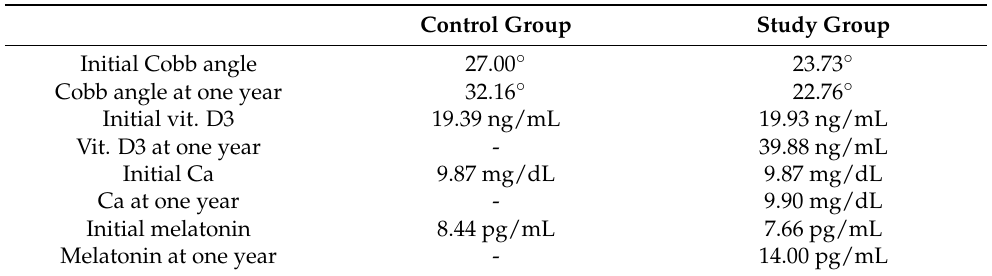
Table 6. Comparison between the level of blood tests taken between the initial moment and 1 year after the applied